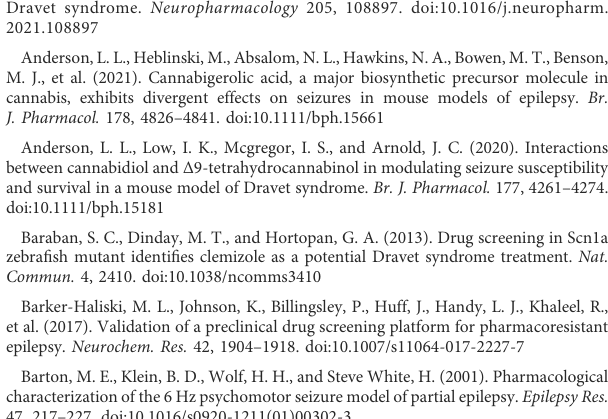
SUPPLEMENTARY TABLE S1 Liquid chromatography-tandem mass spectrometry analyte mass transitions and collision